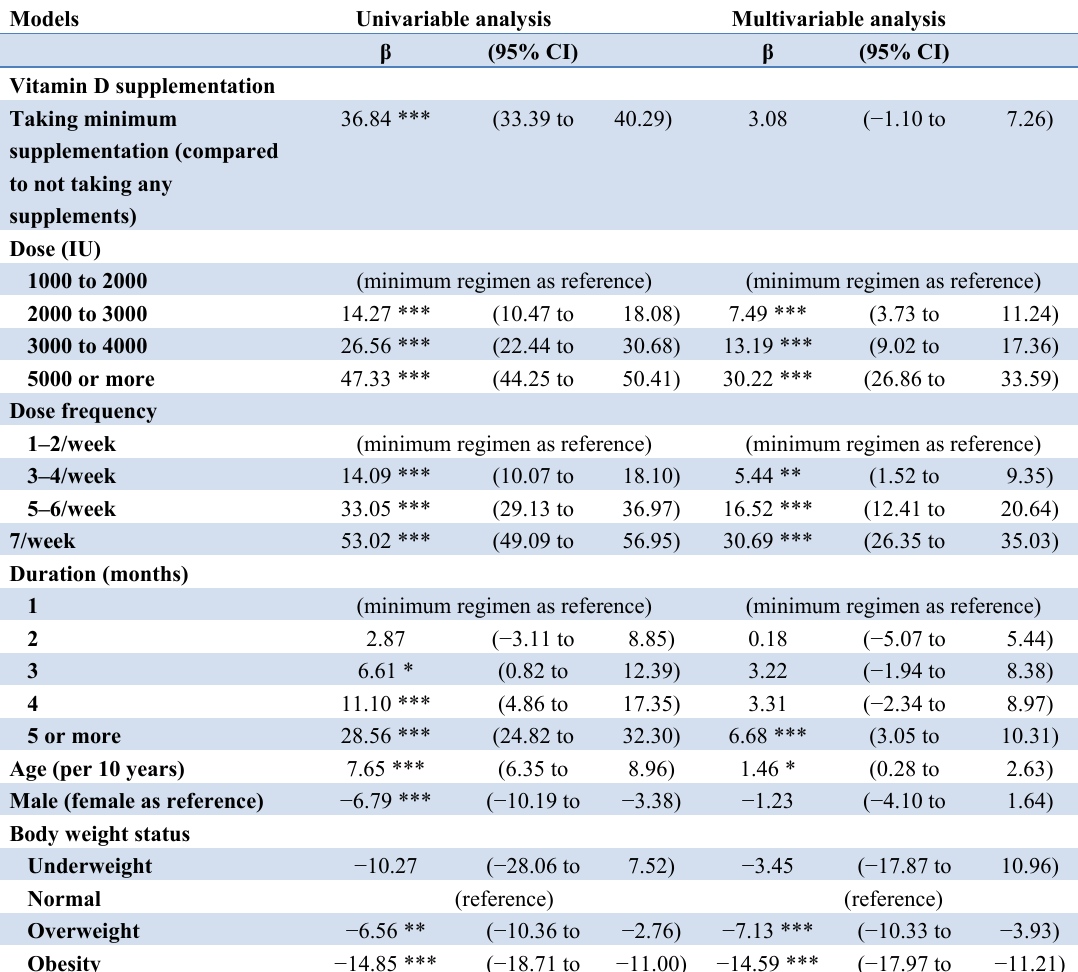
Table 3. The effects of dose, frequency and duration of vitamin D supplementation and individual characteristics on plasma 25(OH)D levels (nmol/L) among participants of a health and wellness